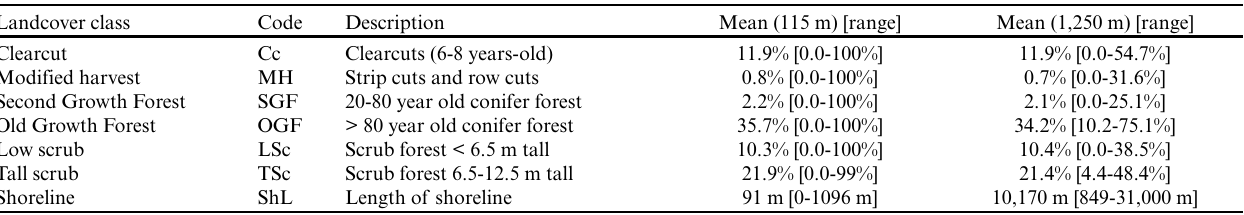
Table 1 . Explanatory landcover variables used to assess habitat use by Gray-cheeked Thrushes (Catharus minimus minimus) in the upper Main River watershed, Newfoundland, 2006-2007. The mean and range of observations of percent cover or linear amount of each class occurring within 115 m and 1250 m of 1613 survey points is listed in the third and fourth columns, respectively. Note that three geographic variables were also evaluated: elevation (Elv; range = 300-600 m), slope (Slope; range 0-60°), and slope position (S. Pos; bottom, midslope, or